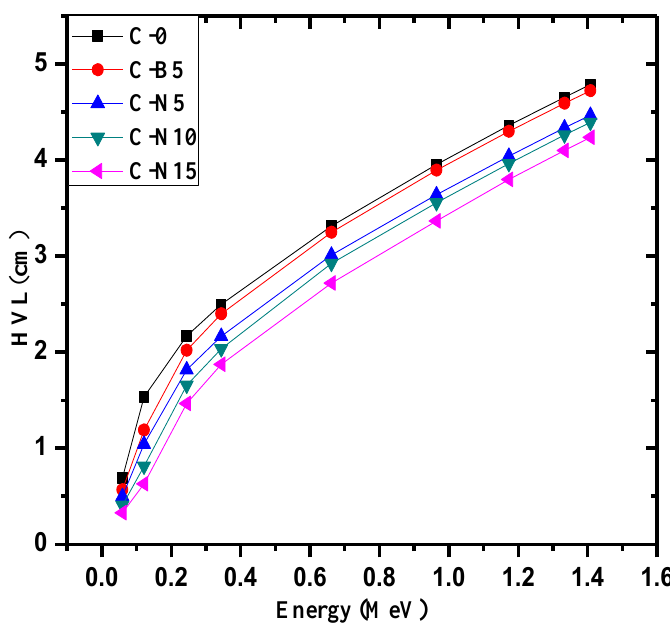
Figure 6. The half-value layer for the C-0, C-B5, C-N5, C-N10 and C-N15. The mean free path (MFP) for the C-0, C-B5, and C-N5 concretes are illustrated against increasing energy in Figure 7. At all energies, MFP increases with increasing en- ergy. This means that the ability of the photons to penetrate the samples under study in- creases with increasing the energy. The MFP of the C-0, for example, increases from 0.986 cm at 0.0595 MeV to 3.06 cm 0.245 MeV, 4.78 cm at 0.662 MeV, 6.25 cm at 1.17 MeV, and 6.76 cm at 1.41 MeV. For the C-N5 sample, the MFP is equal to 0.721, 2.62, 4.35, 5.83, and 6.44 cm for the same respective energies. This increasing trend occurs because higher en- ergy photons have an easier time penetrating through the samples, decreasing the number of collisions, and increasing the distance between collisions, increasing MFP. Another trend can be observed when analyzing the values at a single energy. At 0.662 MeV, for example, the MFP values are equal to 4.78, 5.07, and 5.25 cm for C-0, C-B5, and C-N5, respectively. This trend occurs at all energies and demonstrates that the C-N5 sample has the best shielding ability out of these three concretes.